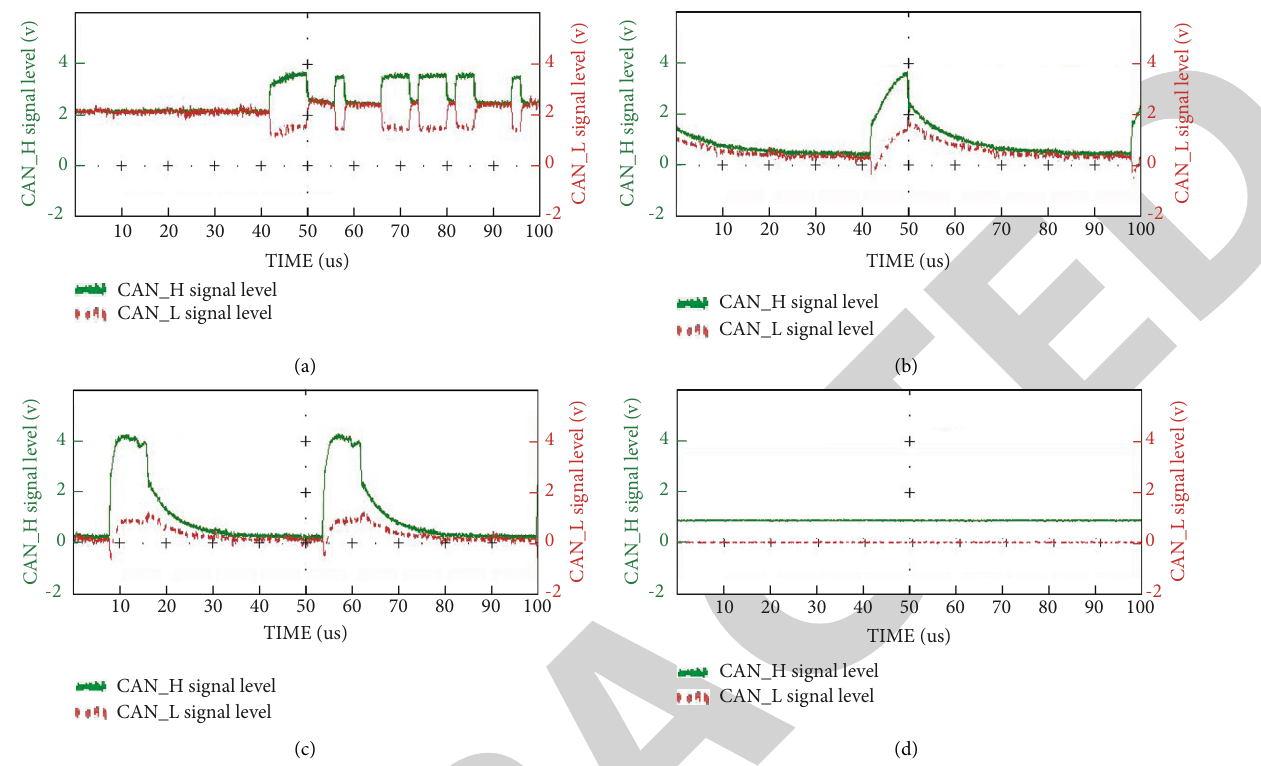
Figure 5: Signal waveform of PT-CAN_L to ground loaded with different resistance. (a) PT-CAN_L Load resistance to ground with 2.5k Ω . (b) PT-CAN_L Load resistance to ground with 75 Ω . (c) PT-CAN_L Load resistance to ground with 30 Ω . (d) PT-CAN_L Load resistance to ground with 0 Ω